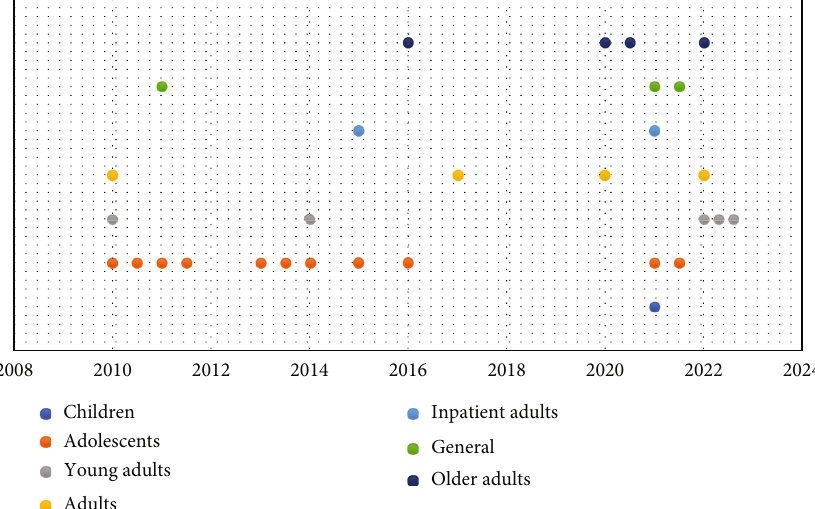
Figure 4: Studies on risk factors for suicide by the target population and year of publication. About 44% ( N = 11 ) of the studies were conducted on adolescents. The least proportion of studies was based on children (27%, N = 3 ). Since 2020, all di ff erent target populations were studied to determine the risk factors for suicide in respective age